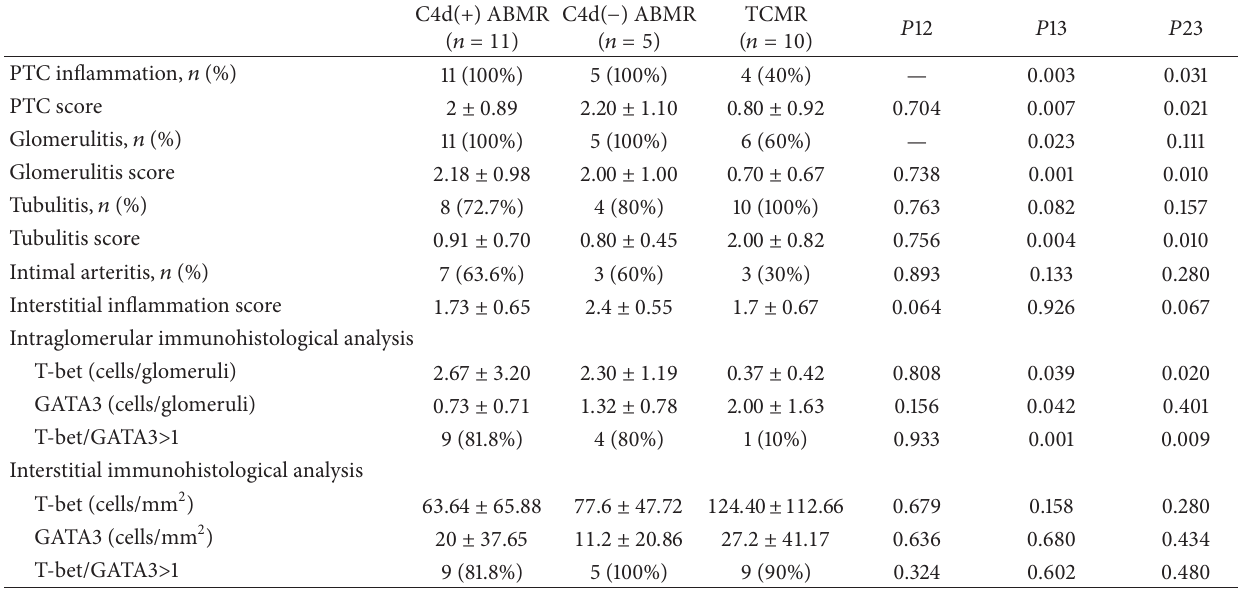
Table 3: Histologic lesion of renal